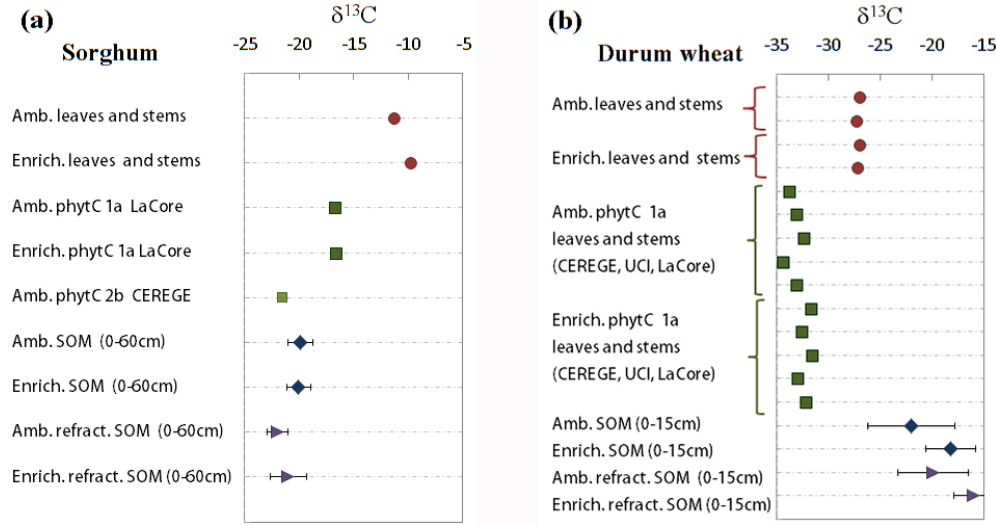
Figure 3. Above-ground C manipulation experiment. δ 13 C values of stems and leaves, phytC, and soil SOM fractions obtained for (a) sorghum and (b) durum wheat experiments. To facilitate comparisons between groups, samples from ambient and enriched CO 2 plots are plotted next to each other. Values are reported as per mil (‰) related to PDB. Results of the bulk and refractory SOM fractions were averaged; consequently results and uncertainties indicate multiple data points. Individual results are shown in Tables S1 and